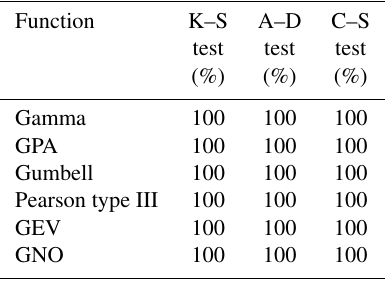
Table 2. Passing rates of the goodness-of-fit test for EP events de- termined using the universal multifractals